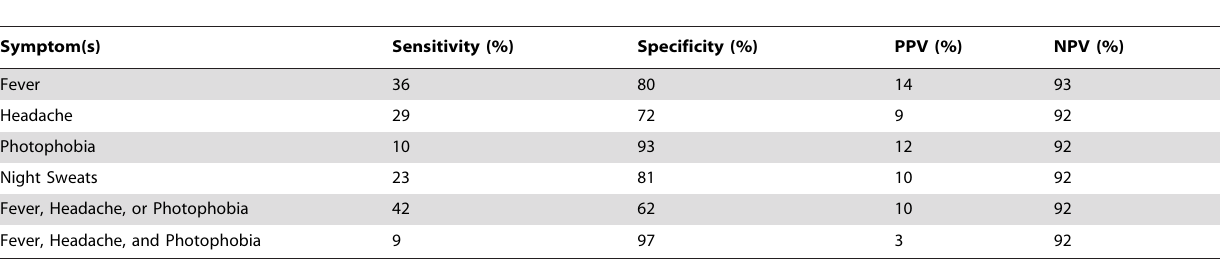
Table 3. Predicting cryptococcal antigenemia based on the presence of individual or combination of clinical symptoms (n=369).